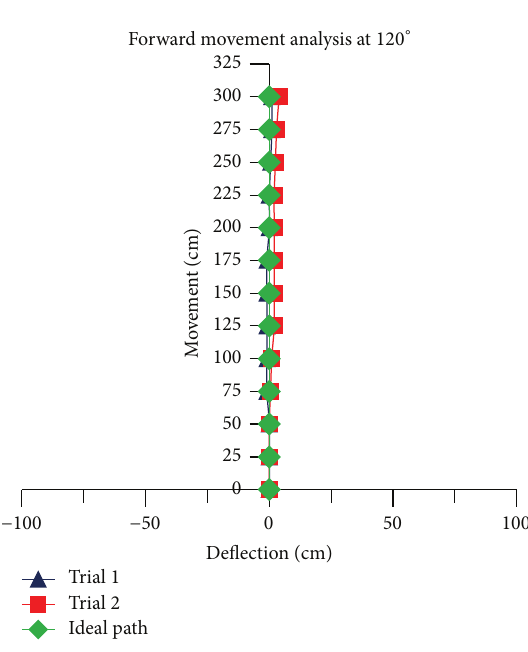
Figure 15: Forward movement versus deflections at 𝜃 = 120 ∘